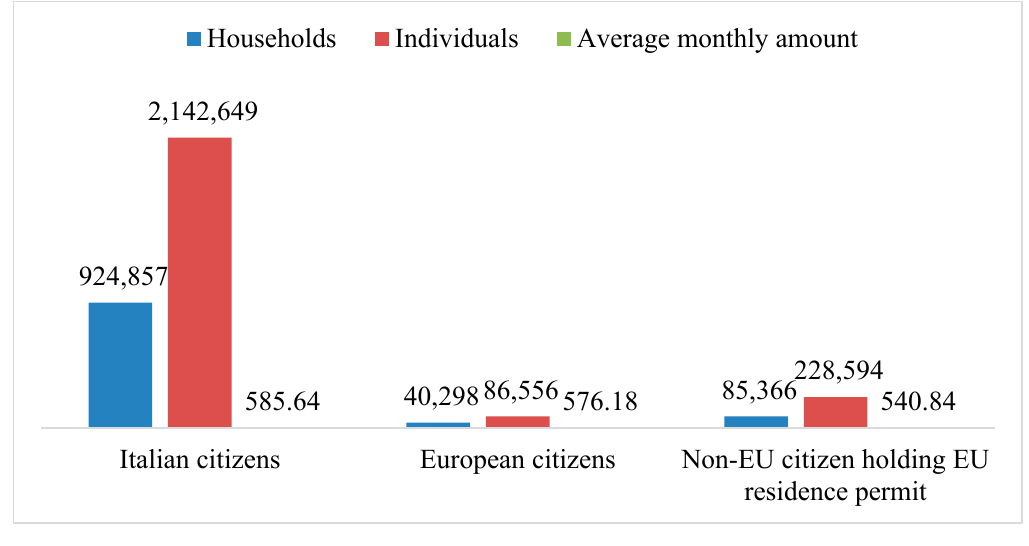
Figure 14. RdC per geographical origin, by household, individuals, and average monthly amount, 2022. Source: own elaboration on the INPS database.